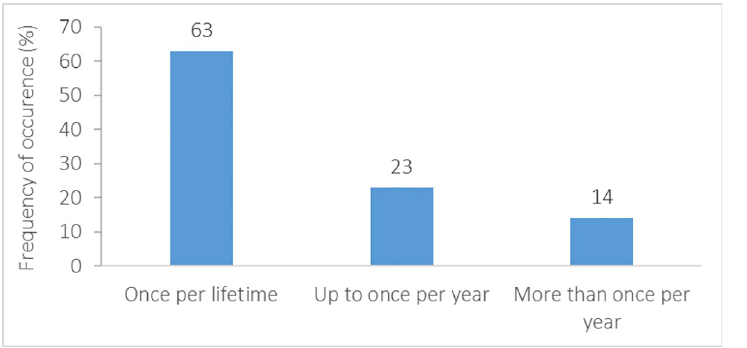
Fig 6. Frequency of relocation of migrating